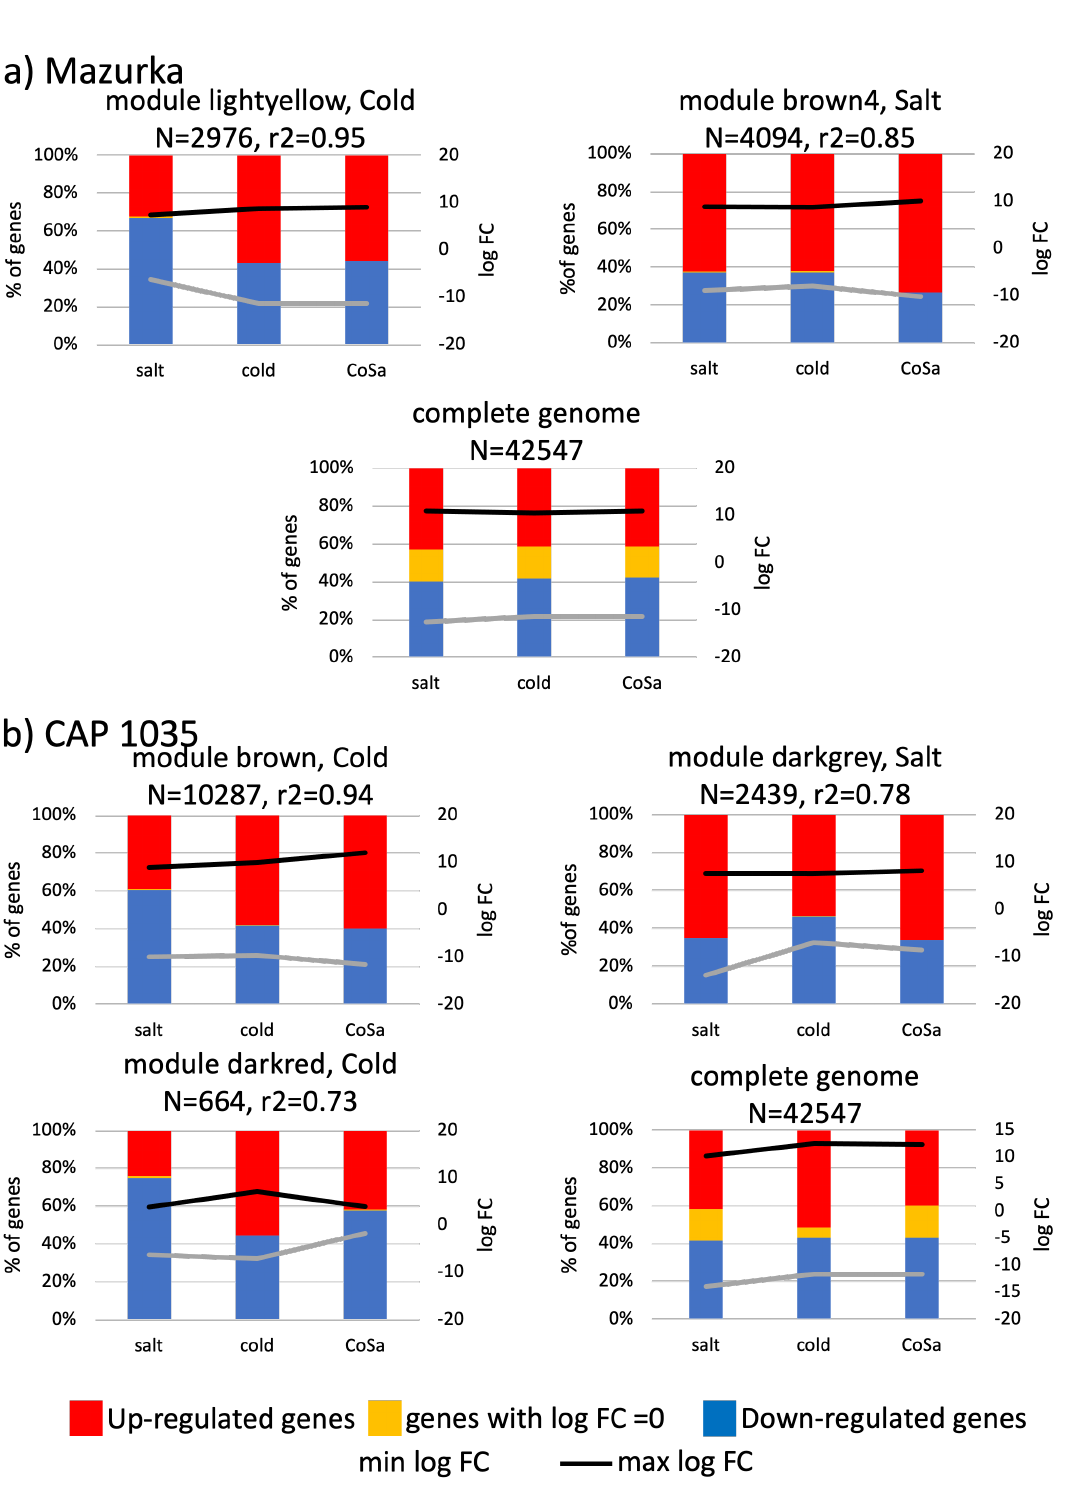
Figure A8. Characteristics of modules from the transcriptome with a high correlation for one binary trait shown for Mazurka (a) and CAP 1035 (b) at d1. RNASeq data was used to perform a weighted cluster analysis. Modules with a correlation of 0.73 and higher were investigated for the presence of up- (red) or down-regulated (blue) genes. Genes having a log 2 FC = 0 are indicated in yellow. The absolute maximal log 2 FC (black line) and minimal log 2 FC (grey line) are indicated. Beneath the module name is shown the number of genes within the module. The graph on the bottom shows data for the whole genome.